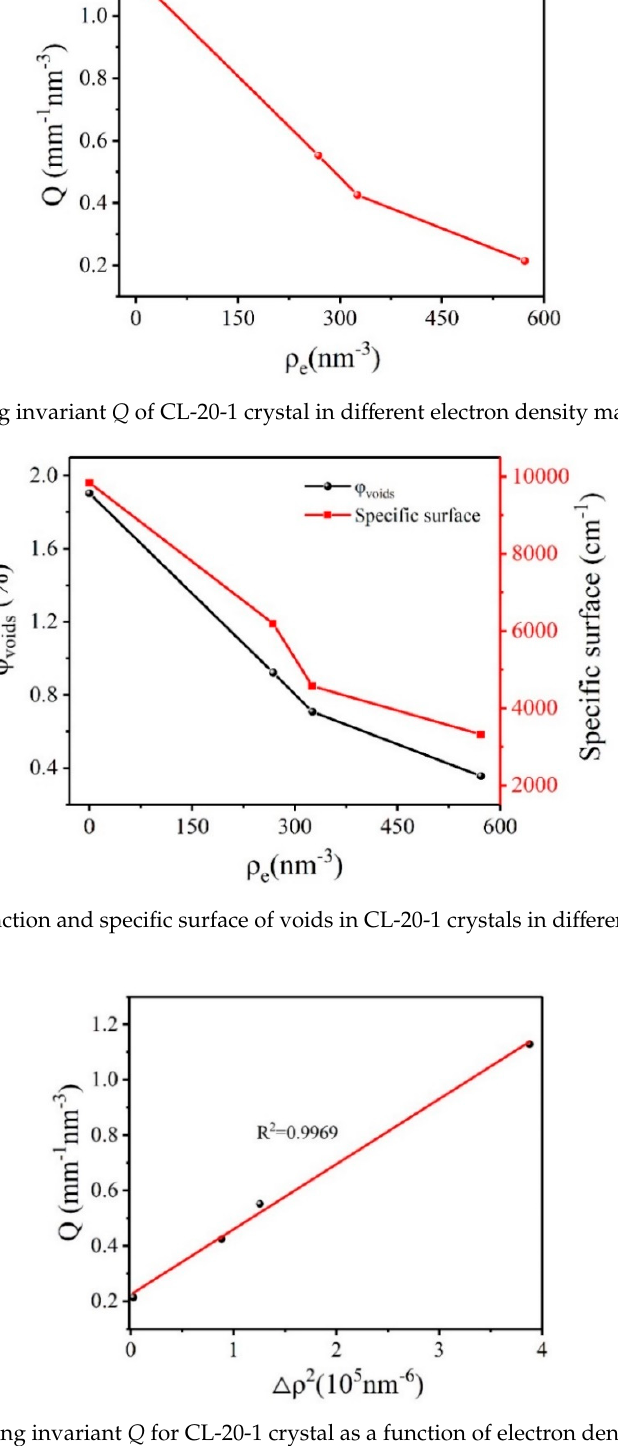
Figure 6. Scattering invariant Q for CL-20-1 crystal as a function of electron density difference.